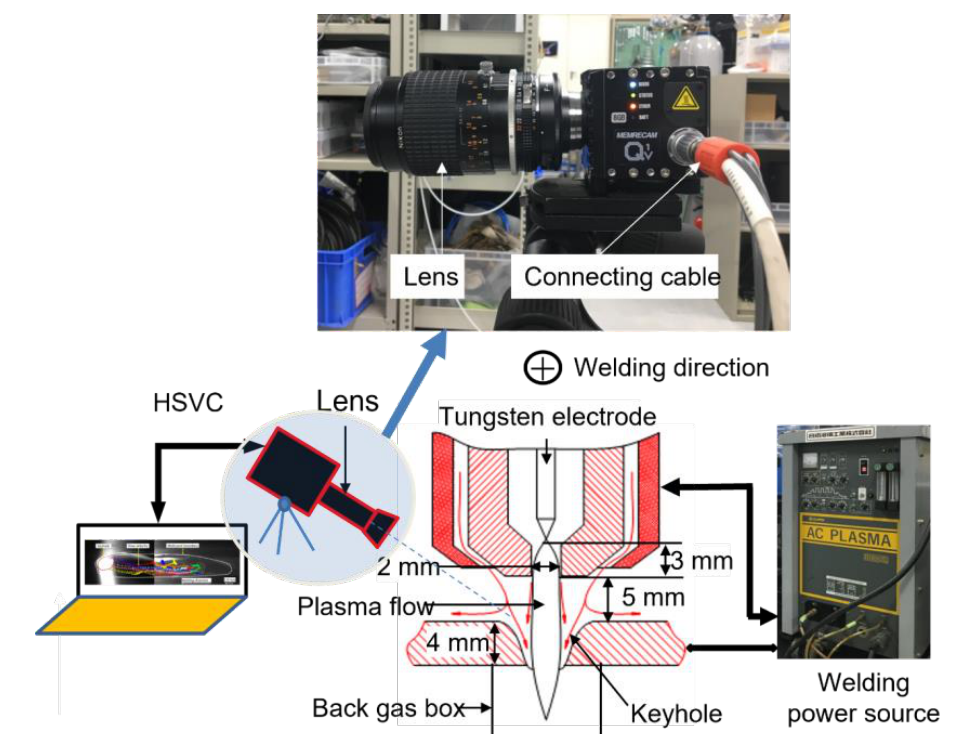
Figure 2. A diagram of the experimental setup for observing material flow on the melted domain surface.